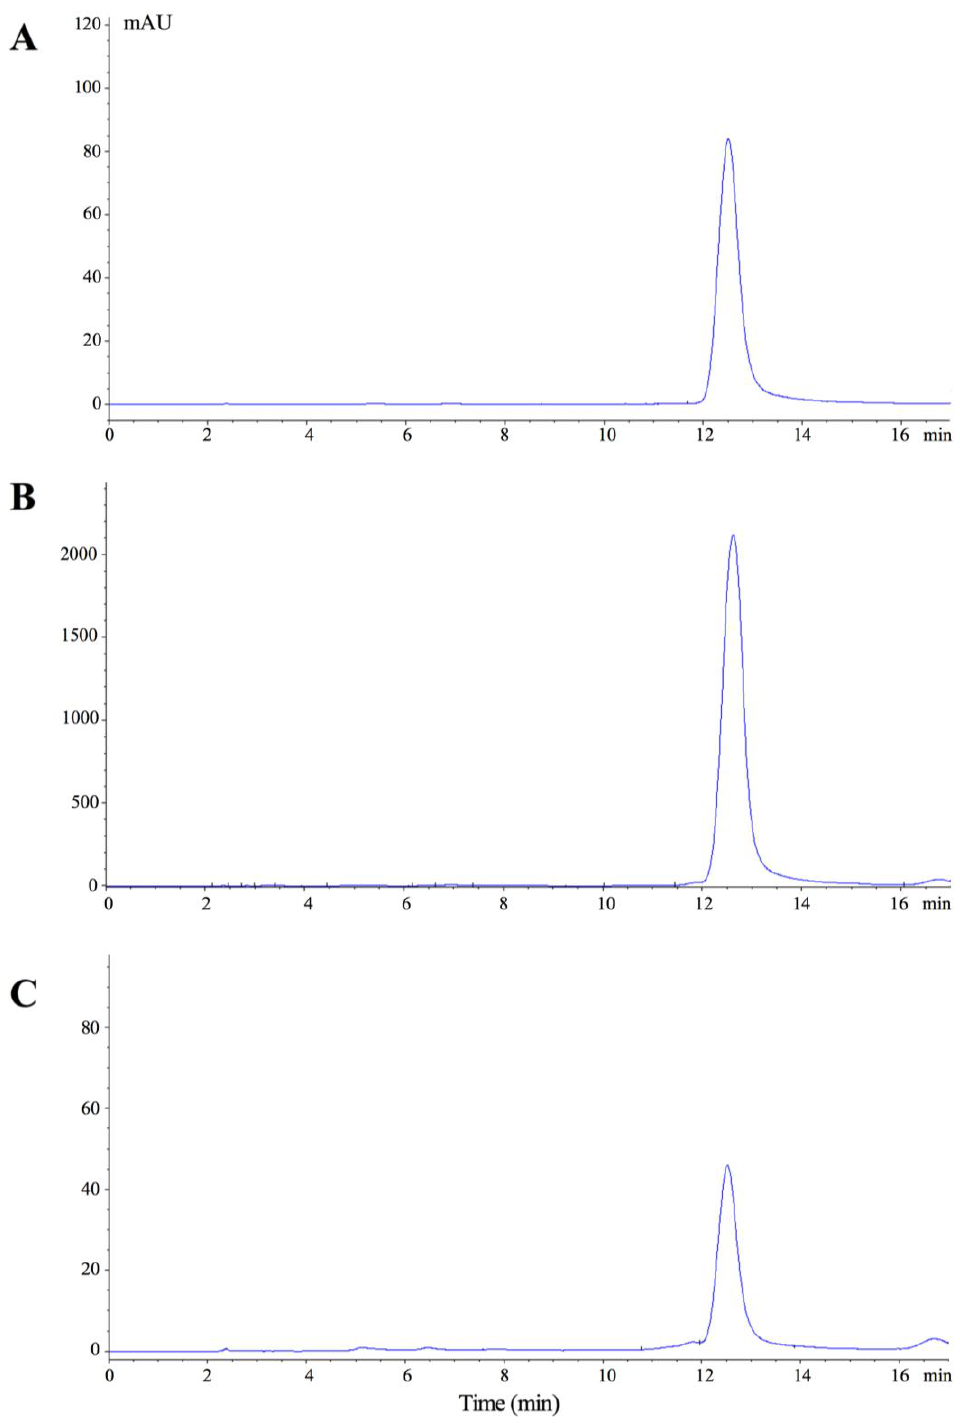
Figure 2. The high-performance liquid chromatography (HPLC) profiles of ( A ) baicalin; ( B ) SB aqueous extract; and ( C ) Nano-SB. Detection was performed at 274 nm, and the retention time of baicalin was assigned at 12.5 min.